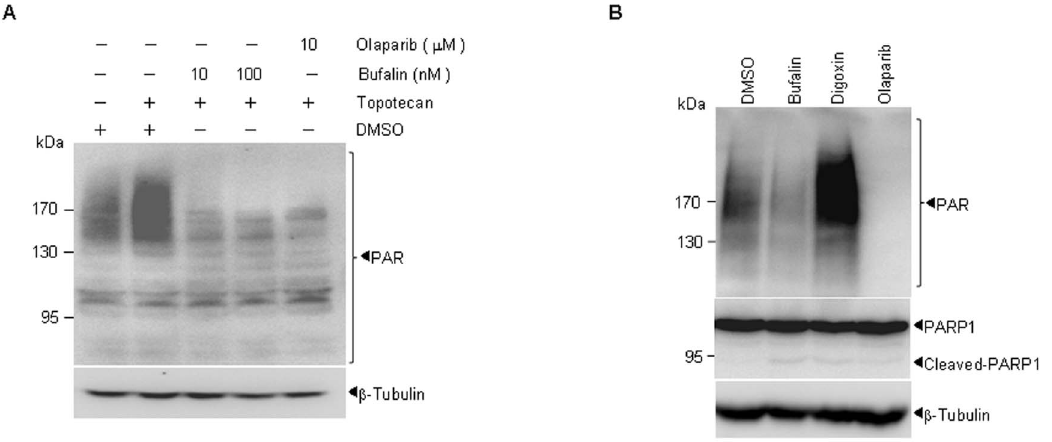
Figure 2. Bufalin functions as an inhibitor of PARP1 in cells. (A) H929 cells were pretreated with indicated concentrations of bufalin or olaparib for 1 h, and then exposed to 100 nM topotecan for another 1 h. Poly (ADP-ribosyl)ation was measured by western blot. (B) H929 cells were cultured with DMSO, 20 nM bufalin, 100 nM digoxin and 20 m M olaparib respectively, and then endogenous PAR expression was quantified by western blot at 48 h. All experiments were repeated for at least three times.